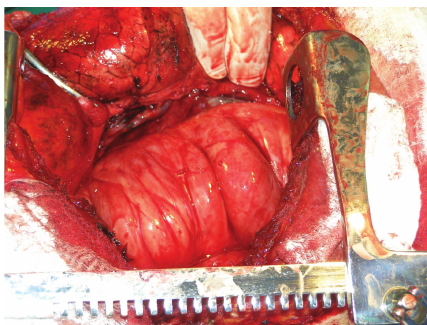
Figure 3: Intraoperative image showing the tumor completely dissected from the lung and covered by the parietal pleura.